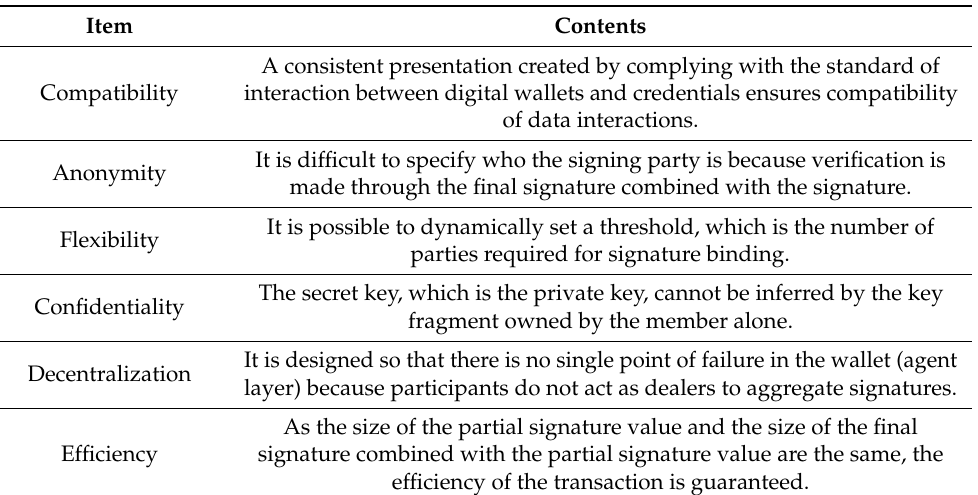
Table 3. Features of the proposed multiparty distributed